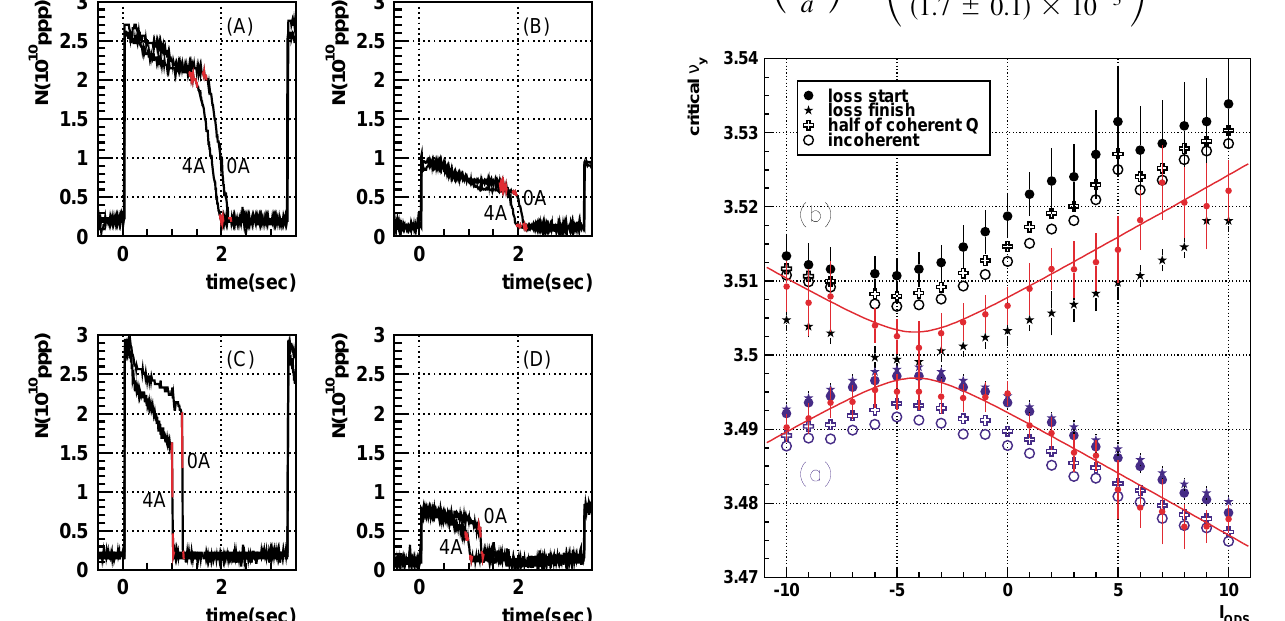
FIG. 6. (Color) Bare tunes corresponding to the times where beam loss began ( t c , solid circles) and was finished ( t f , stars). The open circles and cross symbols show the incoherent (with approximation of linear space-charge field) and half of coherent tunes corresponding to t c . The red symbols show low-intensity